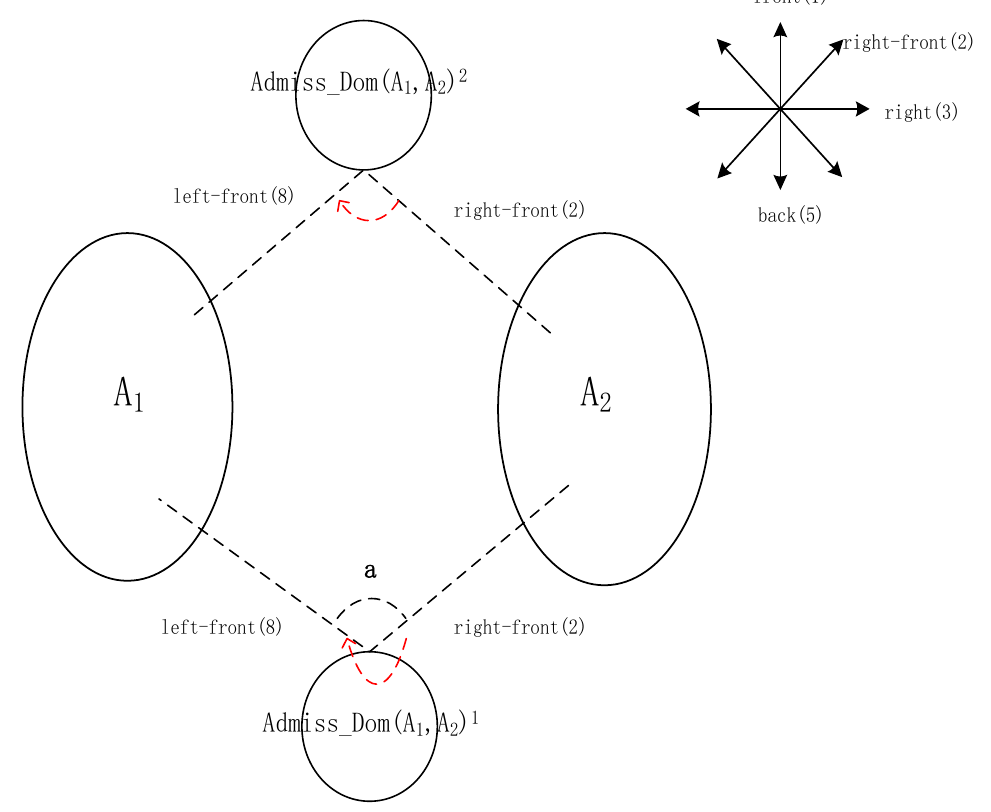
Figure 10. Illustration of the process of obtaining a unique admissible domain with two fuzzy bands: Admiss_Dom(A 1 ,A 2 ) 1 (the direction of rotation is marked with a red dashed line).